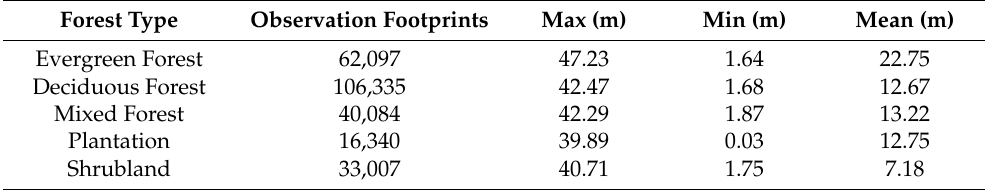
Table 4. GEDI footprints and canopy height range for the different vegetation classes. Forest Type Observation Footprints